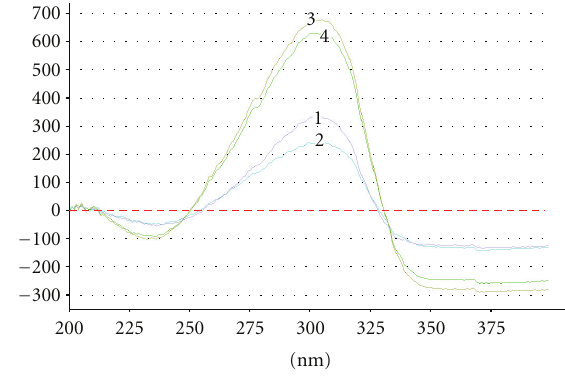
Figure 3: Densitograms of Sample B and ET standard (300nm), Method B.